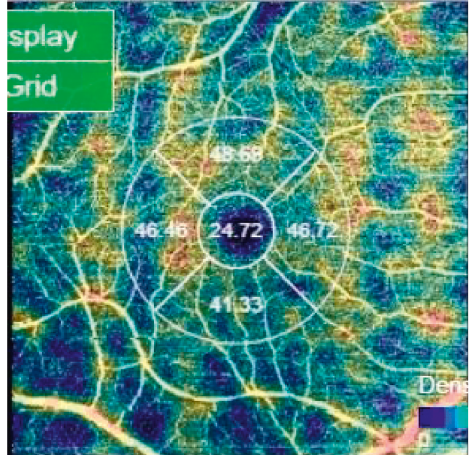
Figure 3: Vessel density at SCP was automatically calculated by the device and reported as a percentage in the central area and four quadrants (superior, nasal, temporal, and inferior). Areas with blood vessels and flow are shown in warm colors (red) and areas without blood vessels are shown in cold colors (blue).